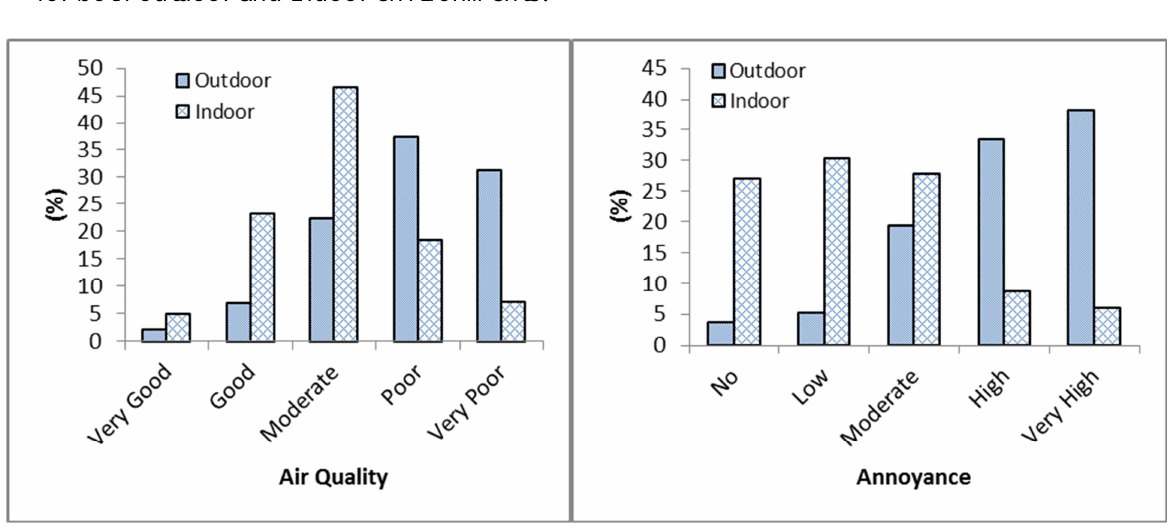
Figure 1. The percentage rating of air quality and the level of annoyance from air pollution for both outdoor and indoor